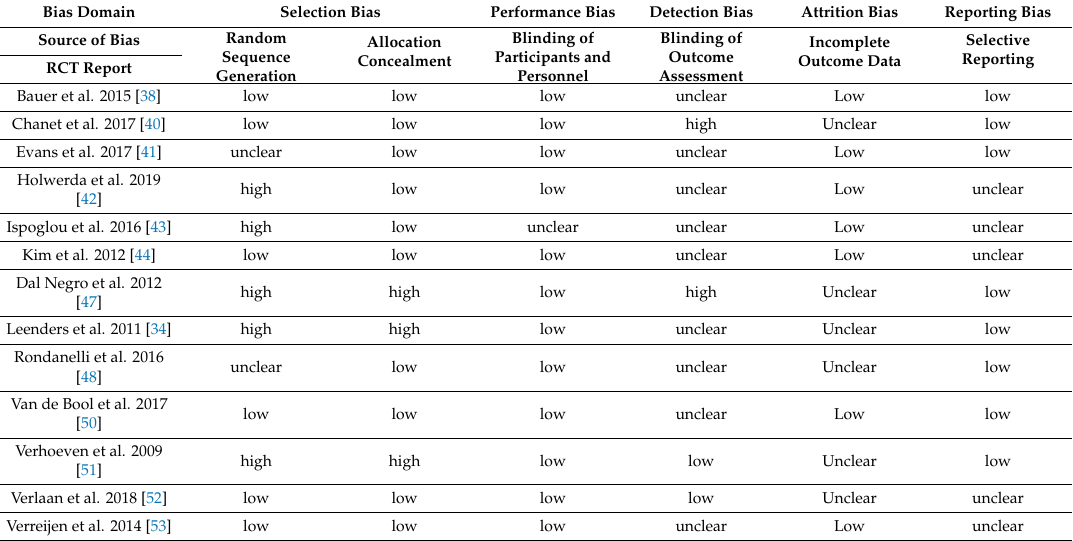
Table 3. Assessment of risk of bias for randomized and placebo-controlled trials